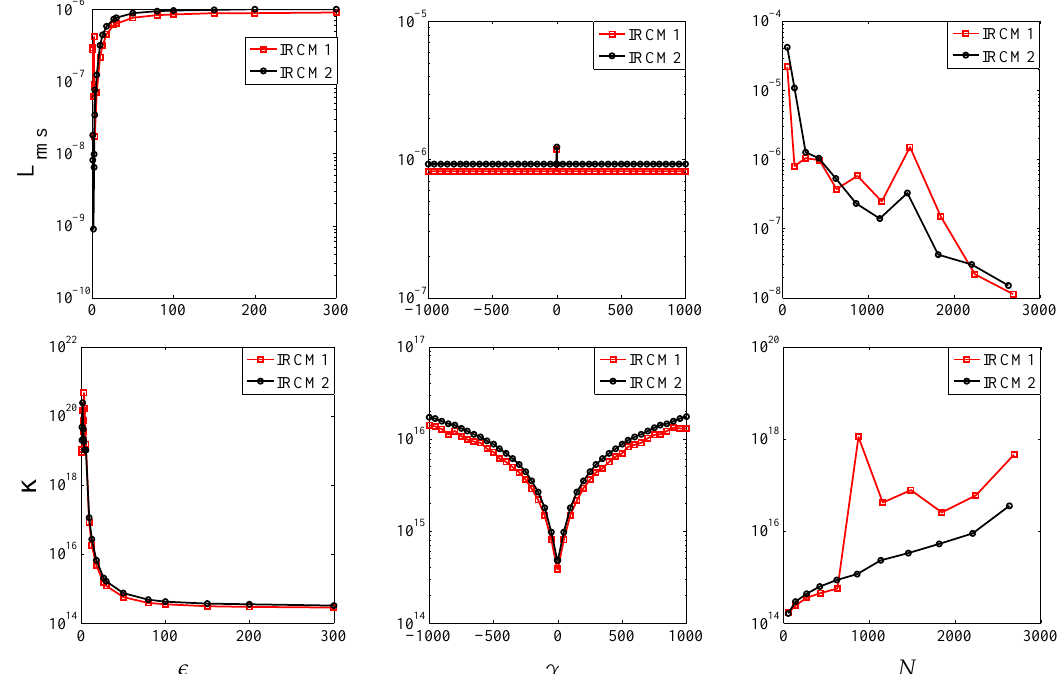
Figure 8. Test Problem 3, accuracy and κ versus (cid:101) , γ and N : ˆ Γ 1 = 67, ˆ Γ 2 = 33, γ = 1, (cid:101) o = 2, (cid:101) = 80, and N = 312 when its influence is